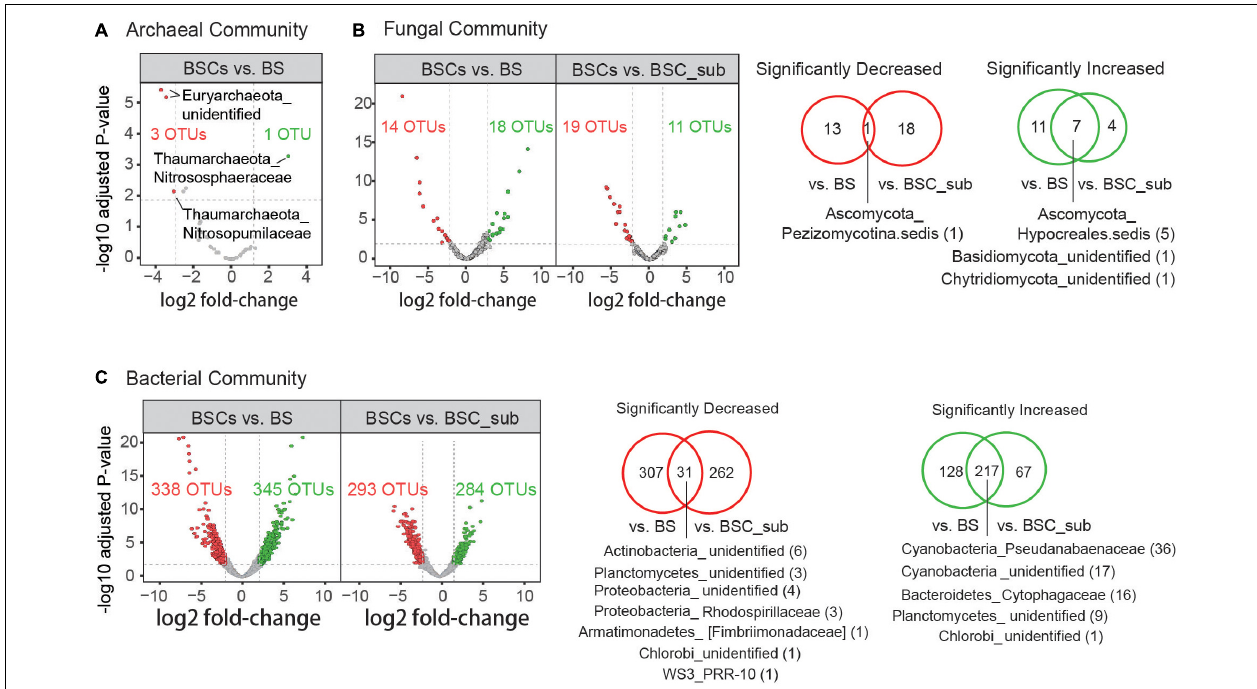
FIGURE 2 | Archaeal, fungal, and bacterial OTUs with significantly altered abundance in BSCs comparing to BS and BSC_sub. Volcano plots represent the significantly increased (green) and decreased (red) OTUs (DESeq2, Benjamini-Hochberg adjusted p -value < 0.01, fold-change within top and bottom 5%) in archaeal (A) , fungal (B) , and bacterial (C) communities in BSCs comparing to BS and BSC_sub as indicated. Log2-transformed fold-change values of the relative abundance ( X -axis) are plotted against adjusted P -values (unify P -value across the main text) ( Y -axis). Venn diagrams illustrate the statistics of significantly increased and decreased OTUs corresponding to the right or bottom panel. Families with the top2 highest numbers of significantly co-altered OTUs are denoted as Phylum_Family (co-altered OTU number). BS, bare soil; BSC_sub, biocrust subsurface soil; BSCs, biocrusts.